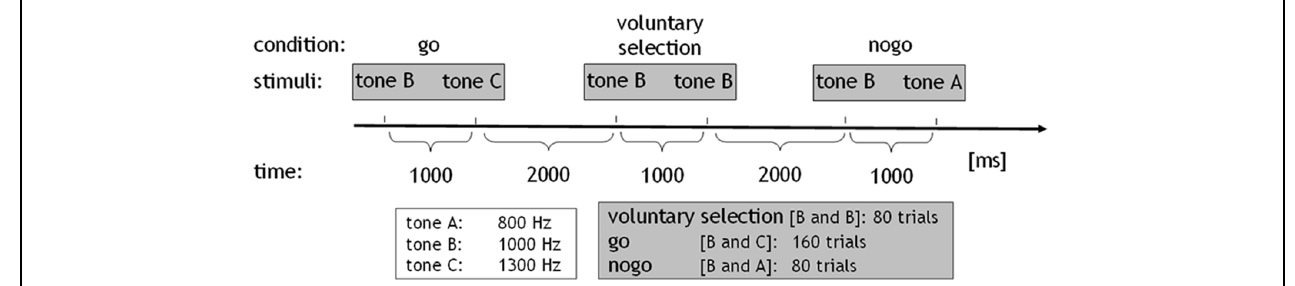
FIGURE 1 | Paradigm: sinusoidal tones of three differential pitches were presented (duration: 50 ms, pressure level: 100 dB). The tones were presented in pairs at intervals of 1000 ms. The interval between trials lasted 2000 ms. The go condition comprised the combination of the middle-frequency tone (tone b: 1000 Hz; cue stimulus) followed by the high-frequency tone (tone c: 1300 Hz). In the nogo task , the cue stimulus was followed by a low-frequency tone (tone a: 800 Hz). In the voluntary selection condition, the cue stimulus was followed by the tone with a same frequency. The go condition was presented 160 times, nogo, and voluntary selection were presented 80